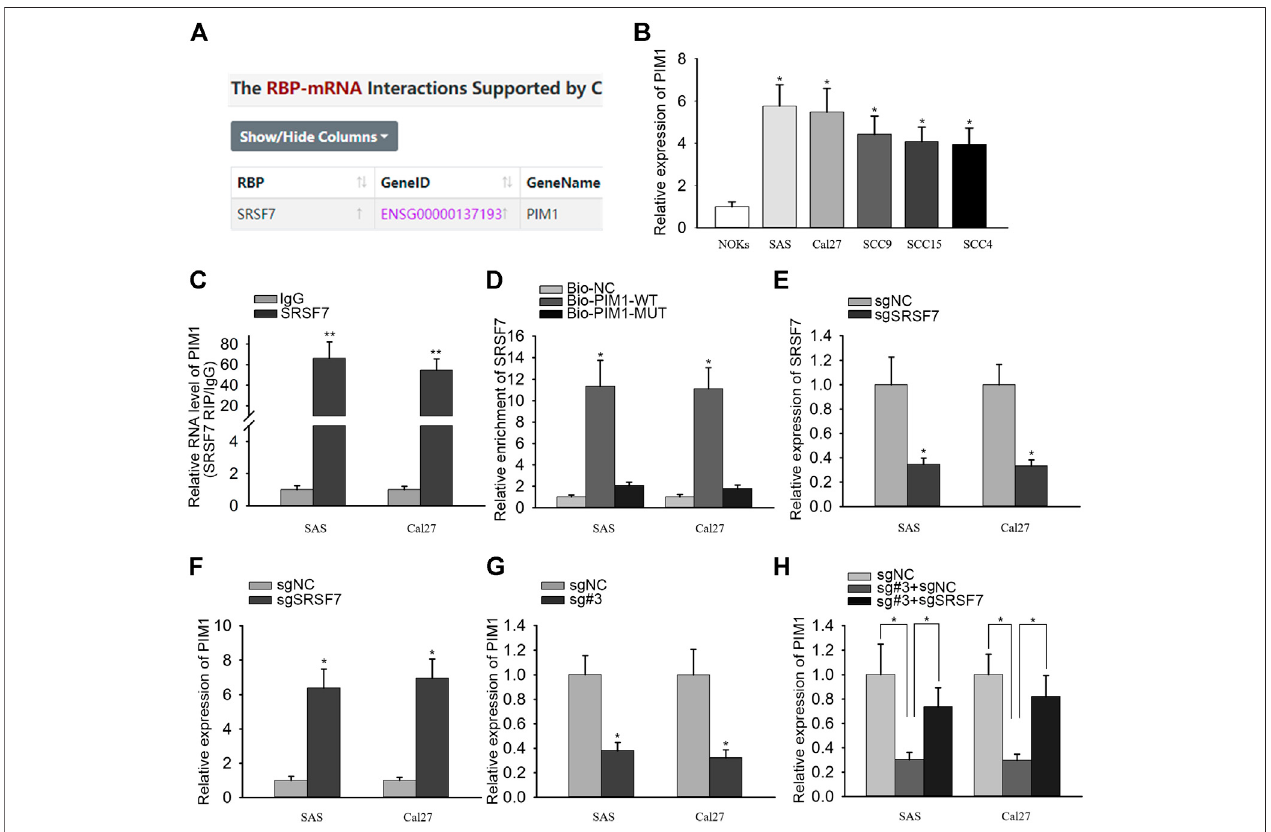
FIGURE 3 | PANDAR affected PIM1 expression by regulating SRSF7 in OSCC. ( A) According to starBase, SRSF7 was identi fi ed as a RBP of PIM1. ( B) . The high expressionlevelofPIM1inOSCCcells.( C,D) TheinteractionbetweenSRSF7andPIM1wascon fi rmedbyRIPandRNApull-downassays.( E,F) ThesgRNAtargetingSRSF7 decreasedSRSF7andincreasedPIM1expression.( G,H) PIM1expressionlevelwasreducedbysgRNAPANDAR#3,andthiseffectwasreversedpartiallybysgRNASRSF7 in OSCC cells. Data were represented as the mean values ( ± SD) of three independent experiments. * p < 0.05 and ** p < 0.01, signi fi cantly different from the